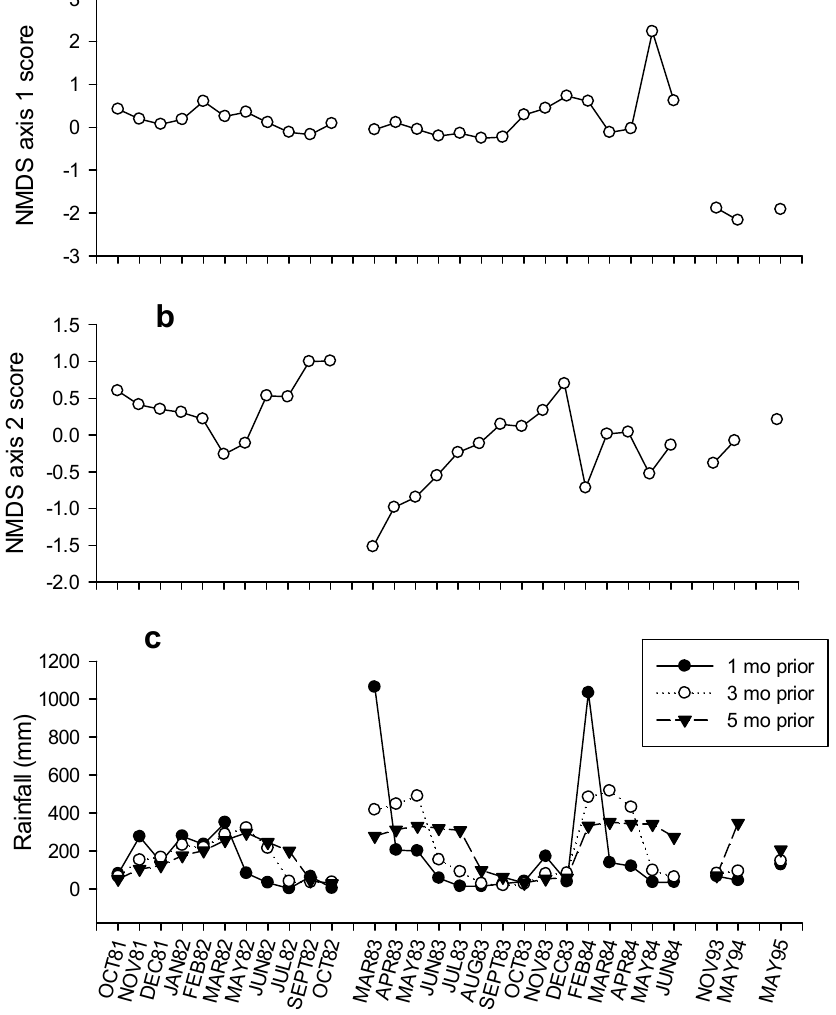
Figure 4. ( a ) Monthly NMDS axis 1 scores and ( b ) monthly NMDS axis 2 scores, over two decades; ( c ) one-month, three-month and five-month antecedent rainfall for each